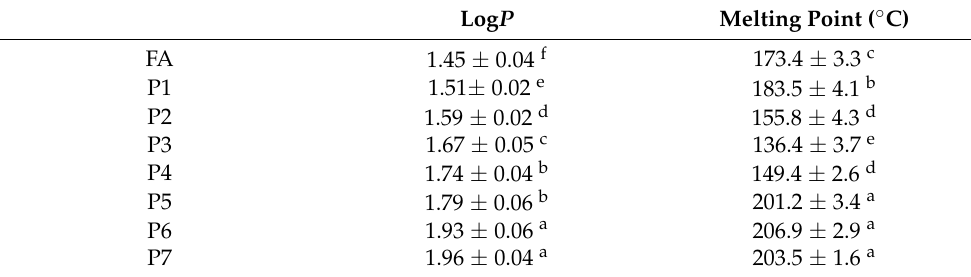
Table 3. Log P and melting point values ( ◦ C) of FA-Laccase-catalyzed oxidation